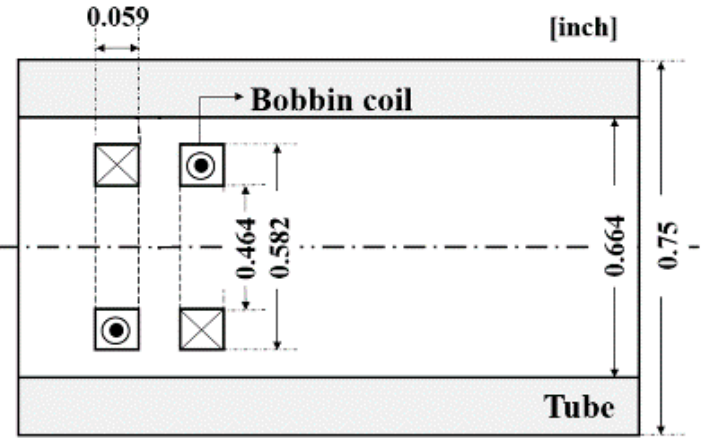
Figure 4. The schematic diagram of the simulation analysis model.